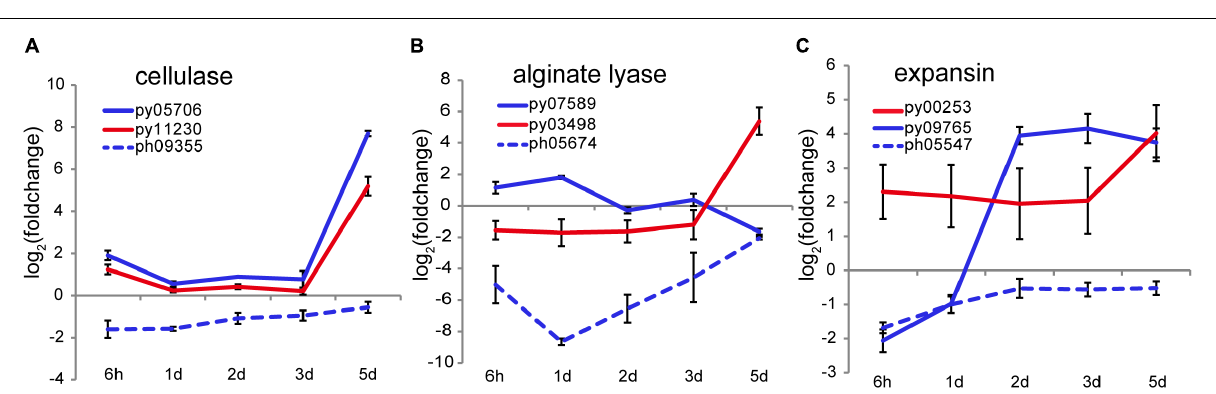
FIGURE 5 | Transcriptional variation of cellulase (A) , alginate lyase (B) , and expansin (C) genes in N. yezoensis and N. haitanensis after wounding. The plots are as described in Figure 2C